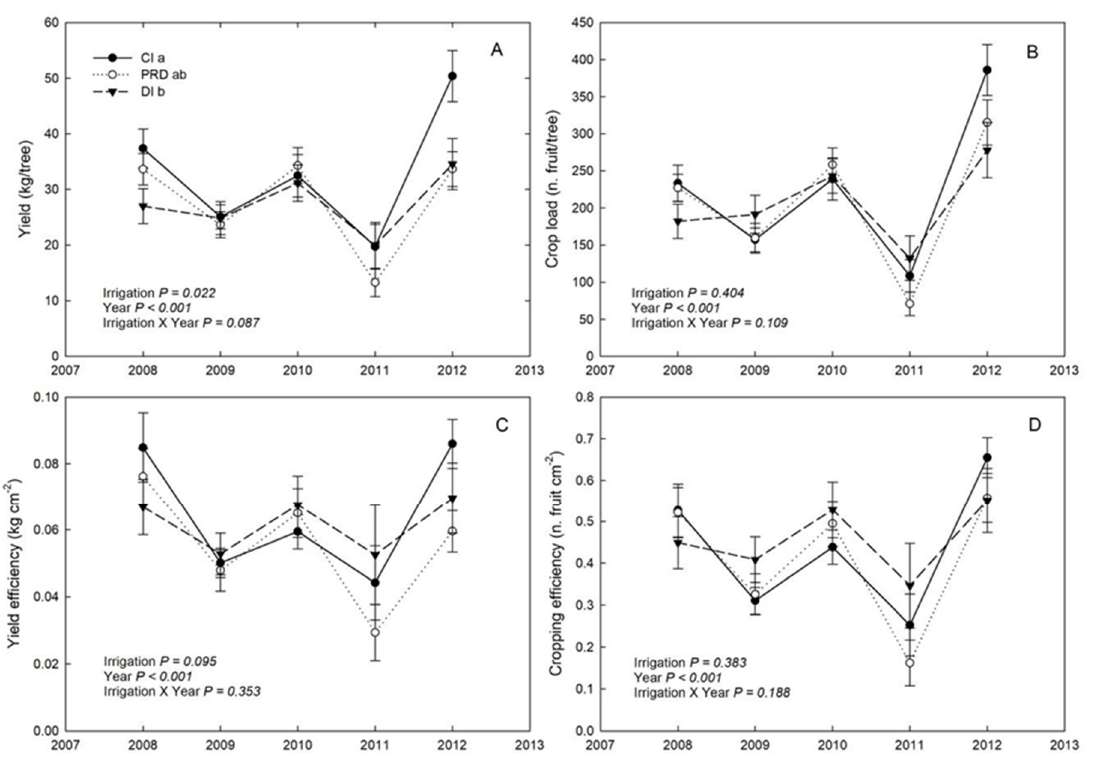
Figure 2. Yield ( A ), crop load ( B ), yield efficiency ( C ), and cropping efficiency ( D ) of adult ‘Valencia’ orange trees under conventional irrigation (CI), partial rootzone drying (PRD), and continuous deficit irrigation (DI). Error bars are standard errors of the means. p -values in each panel are for main factors and interactions from the ANOVA models. Lower-case letters in panel A indicate significant differences among levels of irrigation (Tukey’s multiple range test, p < 0.05).